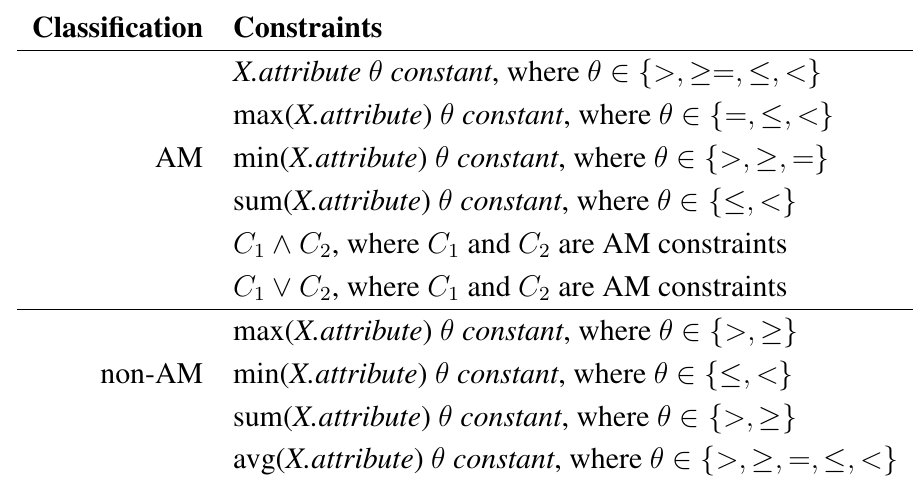
Table 3. Classification of some AM and non-AM